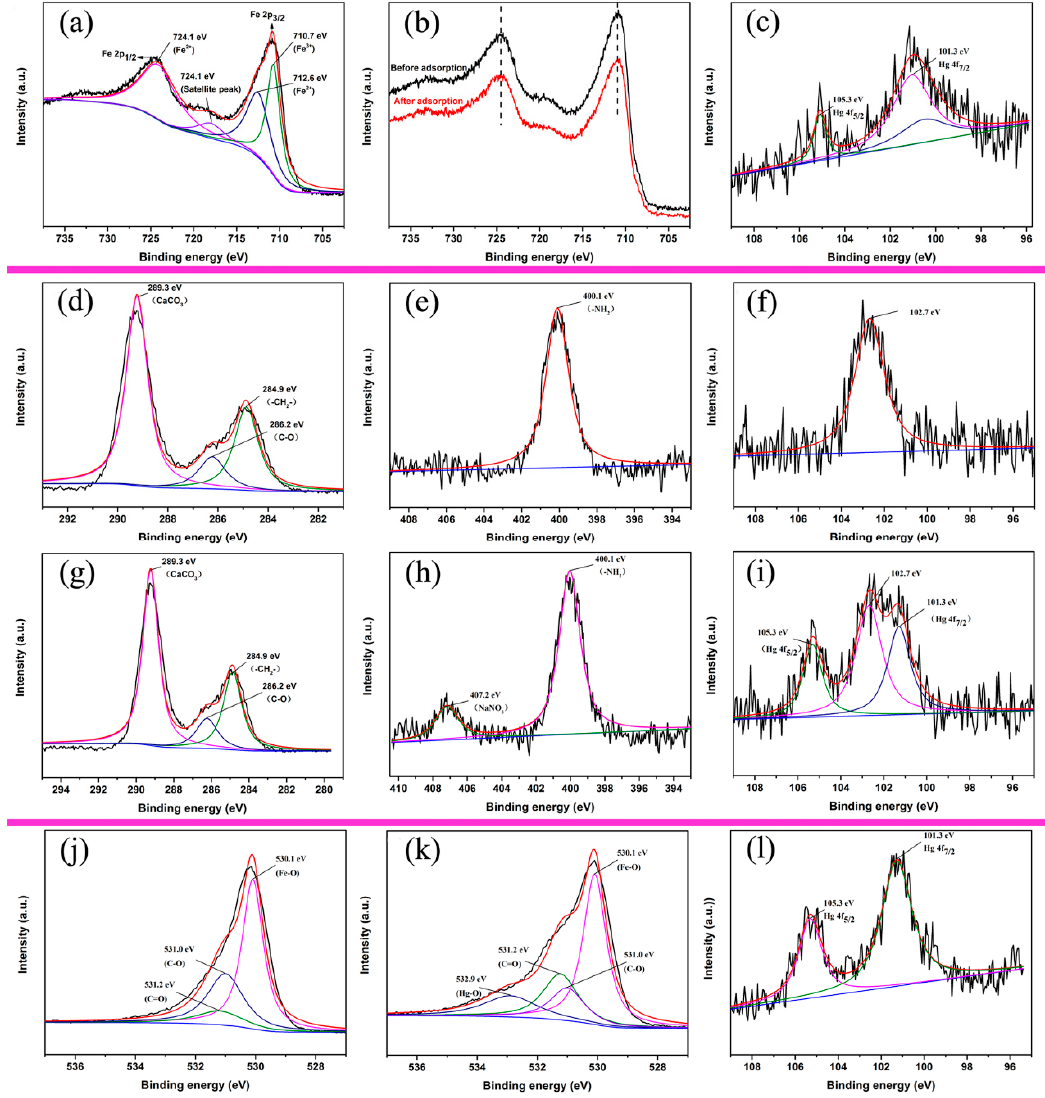
Figure 5. X-ray photoelectron spectroscopy (XPS) spectra of bare Fe 3 O 4 : Fe 2p ( a ) before and ( b ) after Hg(II) adsorption; ( c ) Hg 4f after adsorption. XPS spectra of pristine OS spectra: C 1s, N 1s, Hg 4f before (( d – f ), respectively) and after (( g – i ), respectively) Hg(II) adsorption. XPS spectra of OS / Fe 3 O 4 / HA: O 1s ( j ) before and ( k ) after Hg(II) adsorption; ( l ) Hg 4f after